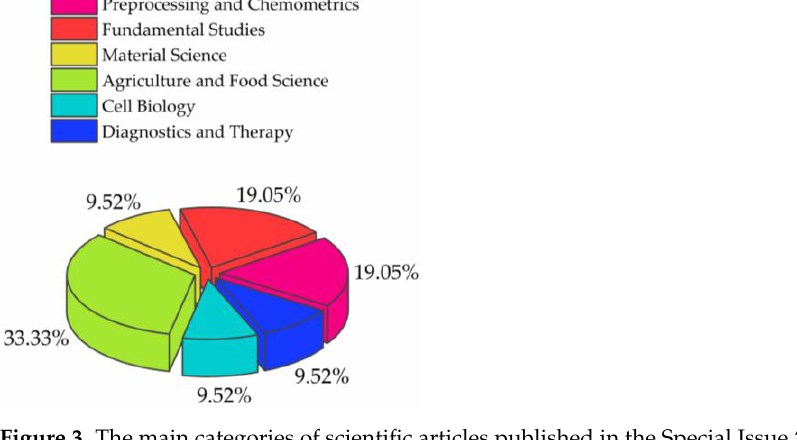
Figure 3. The main categories of scientific articles published in the Special Issue “ Aquaphotomics — Exploring Water Molecular Systems in Nature ” .